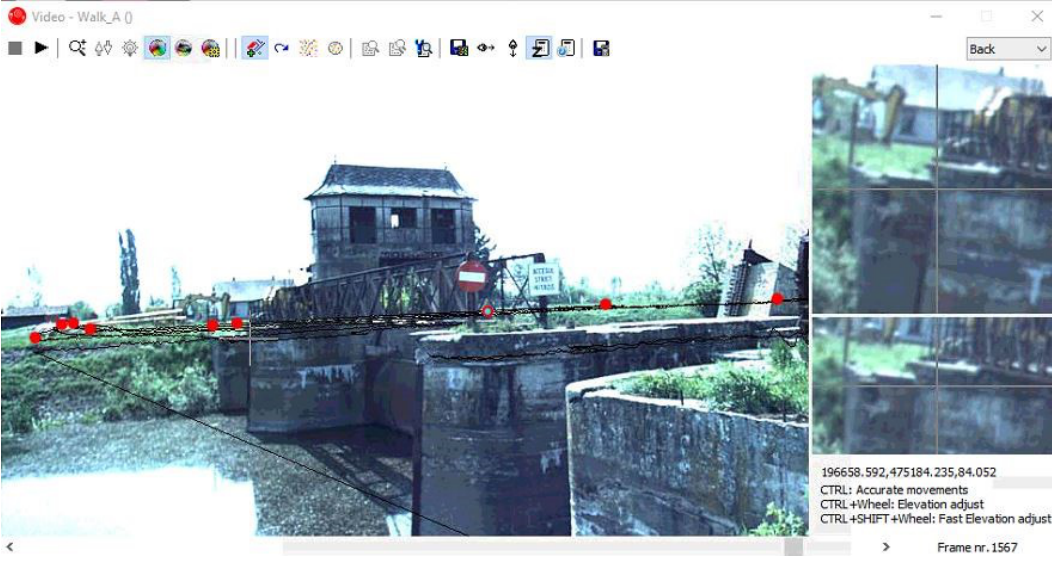
Figure 24. Spherical images of Sânmihaiu Romanian Lock.